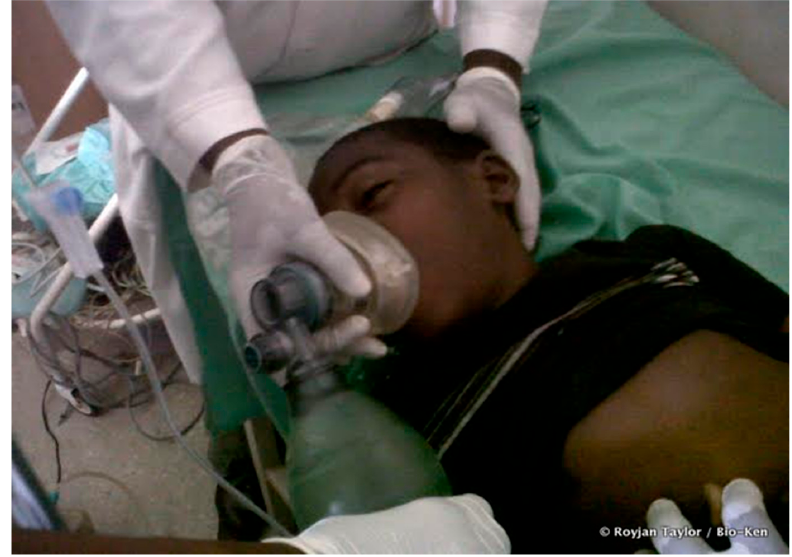
Figure 2. Victim of the black mamba bite.